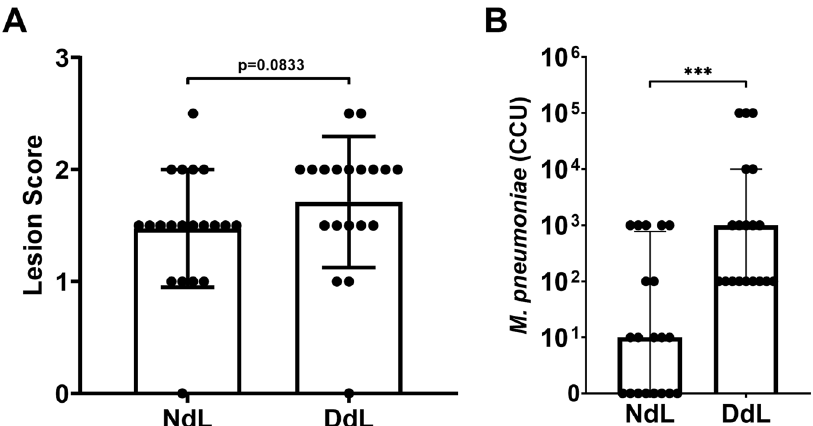
Fig. 4 Vaccination with native or denatured dLAMPs. A Histopathology scoring of lungs from mice intraperitoneally vaccinated with native conformation (NdL) or denatured (DdL) dLAMPs and then intranasally challenged with M. pneumoniae . Data were compared by Mann – Whitney Test and are displayed as median with interquartile range. B Bacterial recovery from lungs from mice intraperitoneally inoculated with NdL or DdL and intranasally challenged with M. pneumoniae . Data points were compared by Mann – Whitney Test, and differences were considered signi fi cant for p < 0.05 (*** p <